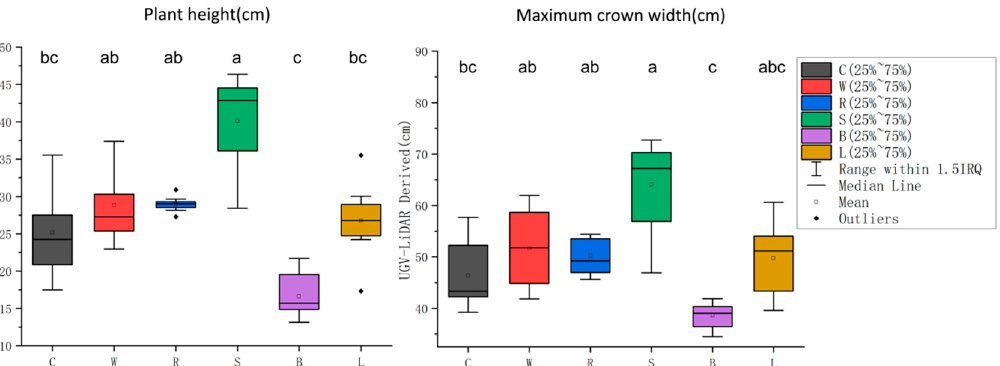
Figure 11. Analysis of plant height and maximum crown width differences. The central horizontal line indicates the median. The top and bottom of the box indicate the 25th and 75th percentile, respectively. The upper and lower solid dots indicate outliers beyond the upper and lower quartiles, respectively; whiskers extend to the extreme non-outliers. The hollow dots represent the mean. Different letters indicate statistically significant differences between species ( p < 0.05).